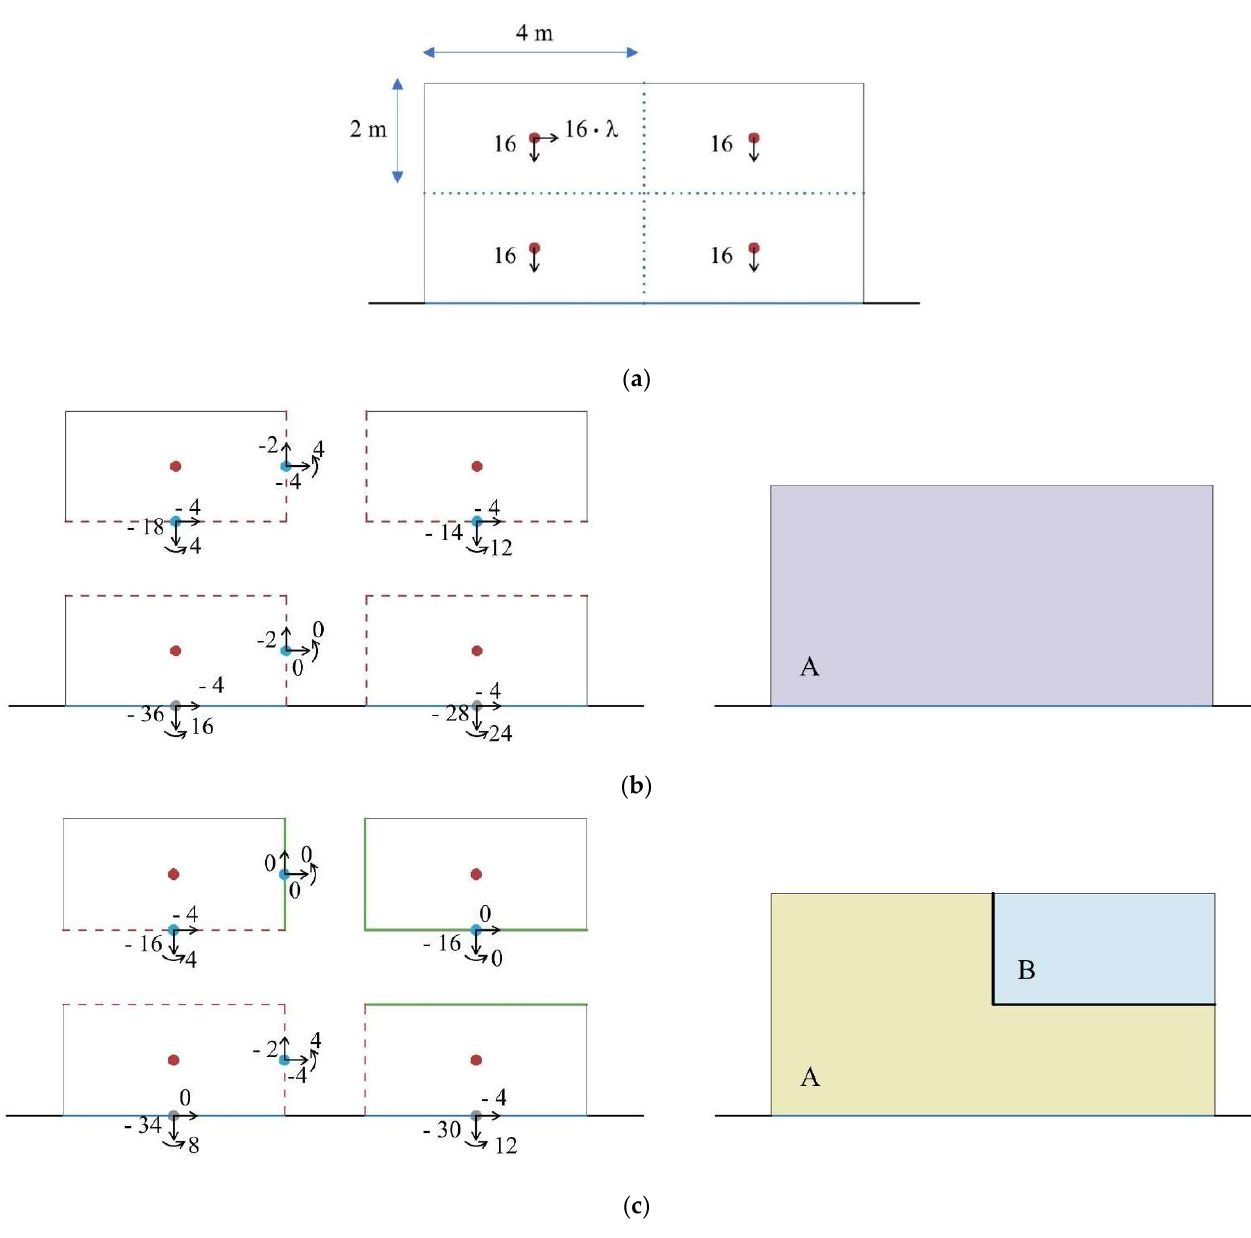
Figure 4. ( a ) A simple 2D problem of a rectangular continuum with no-tension material having four segmenting lines. Internal forces (in Newtons) and moments (in Newton-meters) at the interfaces of: ( b ) the unsegmented model with λ = 0.5; ( c ) the segmental model with λ = 0.25. Capital letters A and B are used to enumerate the segments Given the same loading scheme and material properties, the computed λ for all the possible configurations of the segmental model, named E p1 to E p12 , are presented in Table 1. It is evident that among them, only E p4 has the same load factor as the unsegmented model.